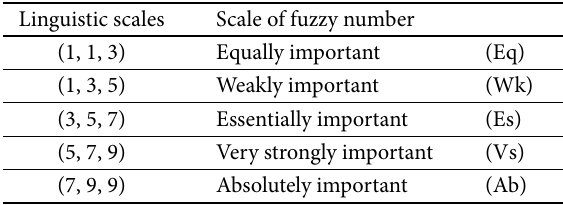
Table 3. Linguistic scale for weight matrix Linguistic